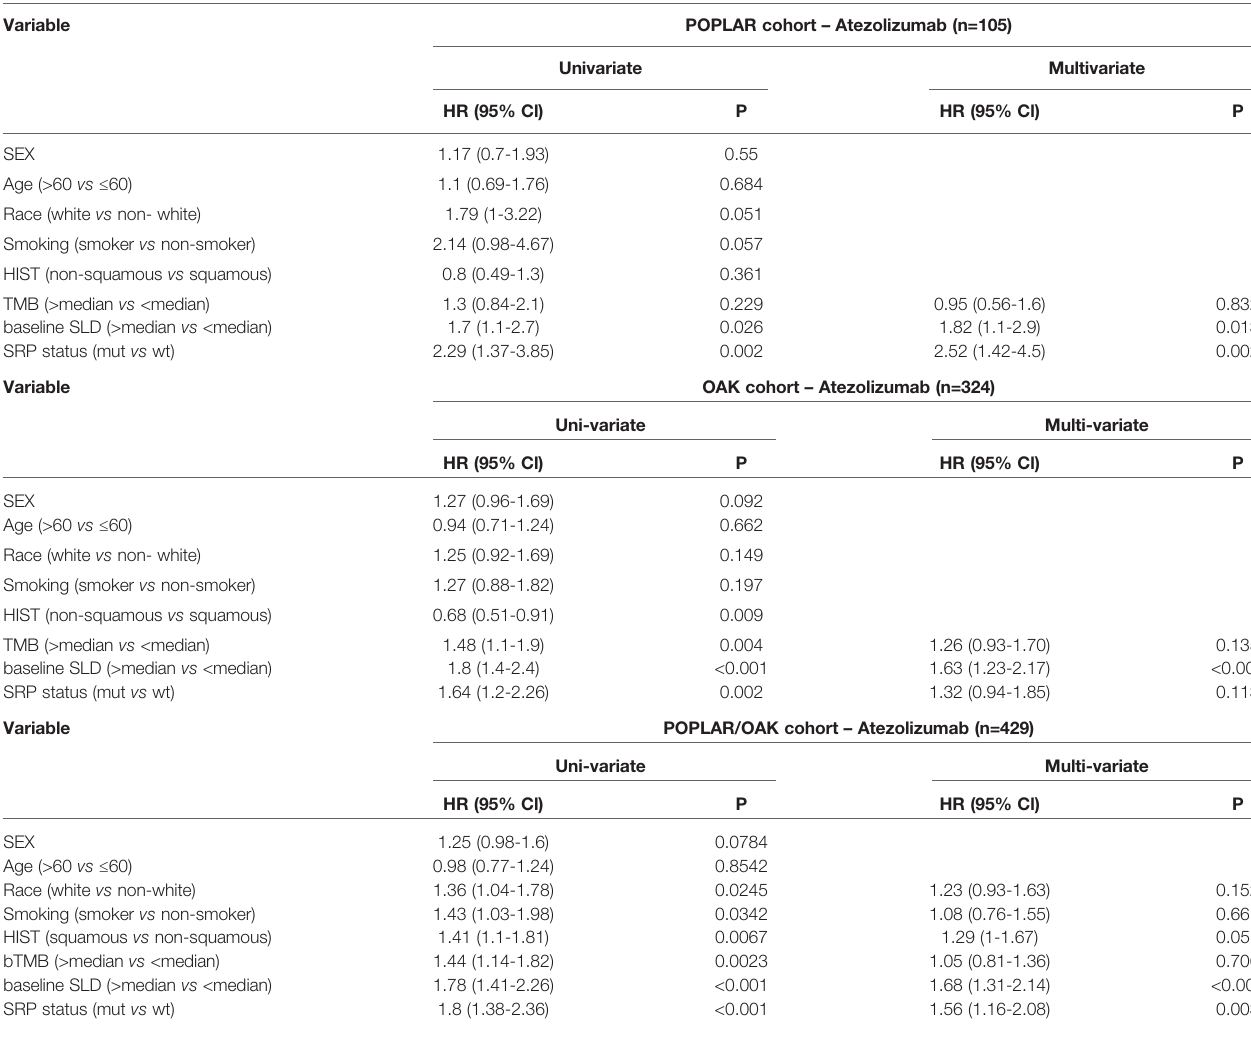
TABLE 2 | Hazard ratio (HR) of clinical and genomic variables on overall survival via univariate and multivariate analysis in patients treated with Atezolizumab.